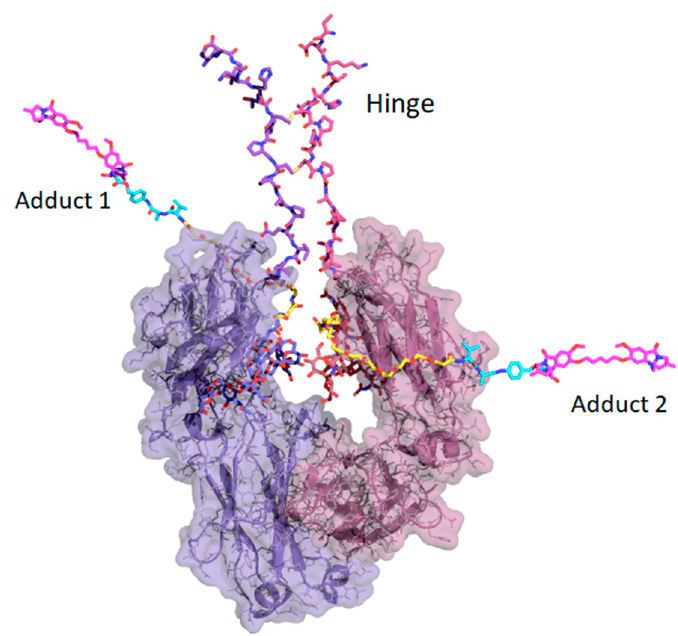
Figure 6. Structure of Fc-C239i with the hinge and full-length conjugates modeled using tesirine (SG3249) added as hypothetical models. Glycans are shown in their observed locations (blue and grey, in the lower cleft). The hinge (upper center) is drawn with its two disulfides, which constrain it and limit the space between the two polypeptides. The two conjugates are attached to the C239i residues in the cleft. Each conjugate is colored with its first portion (maleimide and PEG8 linker) in yellow, and its middle portion (cathepsin cleavage site and linkage-dependent para amino benzoic acid spacer) in cyan. Each conjugate ends with a cytotoxic DNA-modifying pyrrolobenzodiazepine dimer (magenta color). Conjugates are modeled in an extended conformation for clarity. Note that the extended conjugate is long enough (about 6 nm) to wrap around the CH2 domain, and to present its central protease site to cathepsin for cleavage. Although the two conjugates are shown projecting outward on opposite sides of the Fc cleft, it appears possible that they could emerge on the same side, where they could interact with each other.